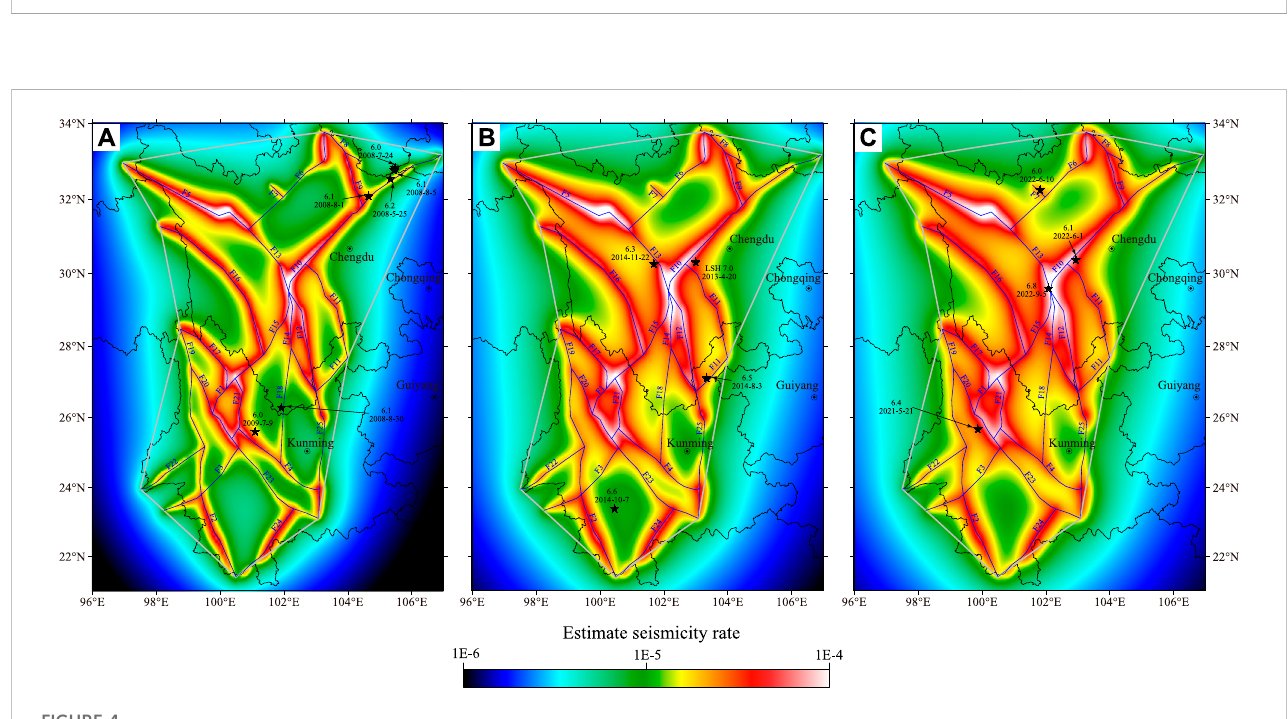
FIGURE 4 Estimated seismicity rate using earthquakes based on the CENC catalog and mapped faults. (A – C) Estimated results using data before May 20, 2008; January1,2013;andSeptember10,2019,respectively.Theblackstarsindicatethetargetearthquakes.ThegraypolygonenclosesthetestareaintheSichuan- Yunnan region. The fault numbers are as indicated in Figure